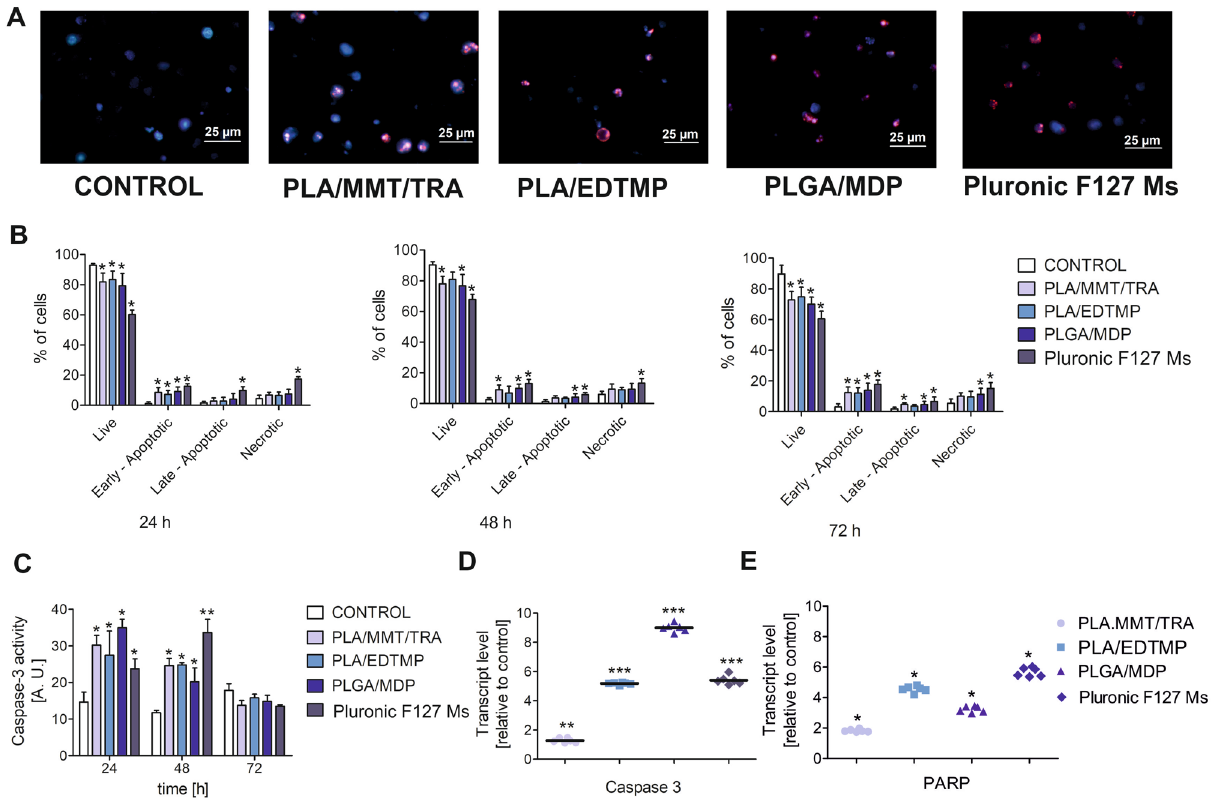
Figure 5. Molecular markers of NP-induced apoptosis in human endothelial cells. ( A ) Double staining with DNA-specific dye (Hoechst 33258 and PI) of HUVEC-STs after NP treatment (100 μg/mL of PLA/EDTMP, PLGA/MDP, and PLA/MMT/TRA or 0.025 μg/mL of Pluronic F127 Ms) for 72 h. Cells were analysed under fluorescence microscope (Olympus IX70, Japan; magnification: 400 ×). ( B ): Quantification of live, early apoptotic, late apoptotic, and necrotic HUVEC-STs at different times following treatment with NPs in the same conditions as described above. Cells were stained with a mixture of Hoechst 33258/PI. Representative data are shown from three separate experiments. p < 0.05 for significant differences between NP-treated and control cells ( C ) Time-dependent changes in caspase-3 activity in HUVEC-STs treated with various concentrations of NPs (100 μg/mL of PLA/EDTMP, PLGA/MDP, and PLA/MMT/TRA or 0.025 μg/mL of Pluronic F127 Ms) for 24, 48, and 72 h. Results represent the means ± SD of three independent experiments. *p < 0.05 for significant differences between NP-treated and untreated control cells. ( D ) Caspase-3 and PARP transcription levels (relative to HPRT1) in HUVEC-STs exposed to examined nanosubstances: PLA/EDTMP, PLGA/MDP, and PLA/MMT/TRA (100 μg/mL) or Pluronic F127 Ms (0.025 μg/mL) for 24 h. Asterisks refer to significant differences (*p < 0.05, **p < 0.01, and **p < 0.001; n = 3) in transcription levels in NP-treated cells compared to untreated